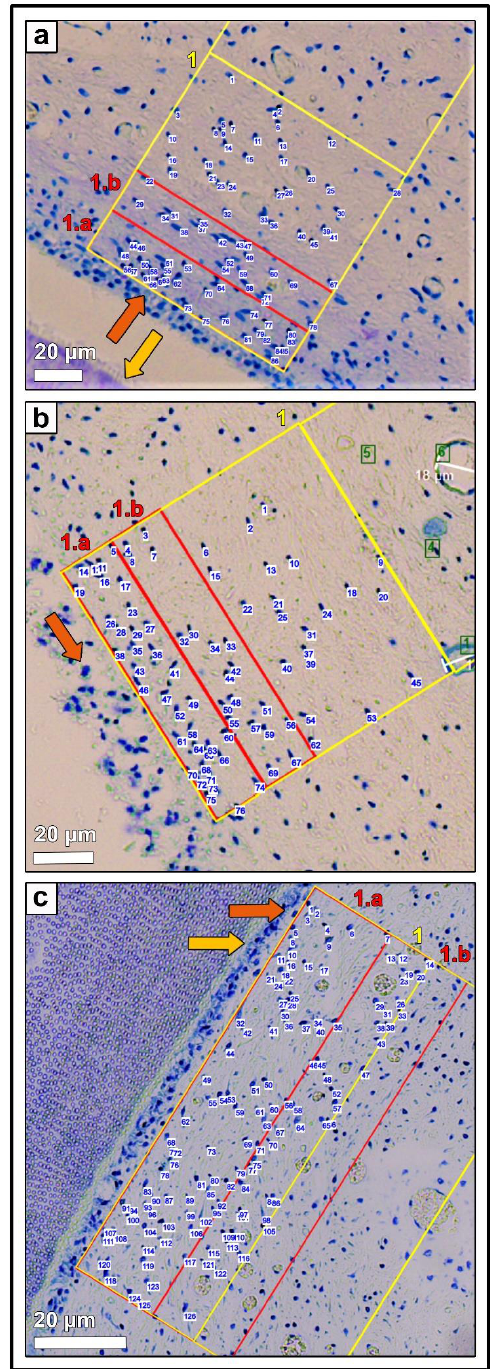
Figure 7. ( a ) Horizontal histological section (c) of a deciduous incisor (801) of a foal (210 days-old, AG 1), toluidine blue stain. Zones 1.a and 1.b (red rectangle) and zone 1 (yellow rectangle) are indicated, orange arrow: odontoblastic layer, yellow arrow: predentin layer. Blue numbers mark the counted fibroblastic cell nuclei. ( b ) Horizontal histological section (c) of a permanent incisor (401) of an adult horse (12 years-old, AG 2), toluidine blue stain. Zones 1.a and 1.b (red rectangle) and zone 1 (yellow rectangle) are indicated, orange arrow: odontoblastic layer. Blue numbers mark the counted fibroblastic cell nuclei. ( c ) Horizontal histological section (c) of a permanent cheek tooth (108) of an adult horse (21 years-old, AG 3), toluidine blue stain. Zones 1.a and 1.b (red rectangle) and zones 1 (yellow rectangle) were indicated, orange arrow: odontoblastic layer, yellow arrow: predentin layer. Blue numbers mark the counted fibroblastic cell